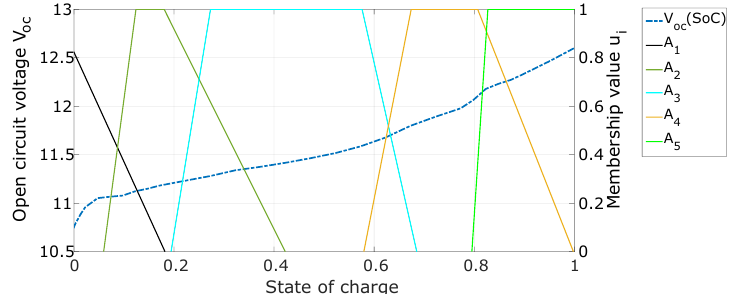
Figure 5. Modeling the relationship between the V oc and SoC using a set of trapezoidal fuzzy